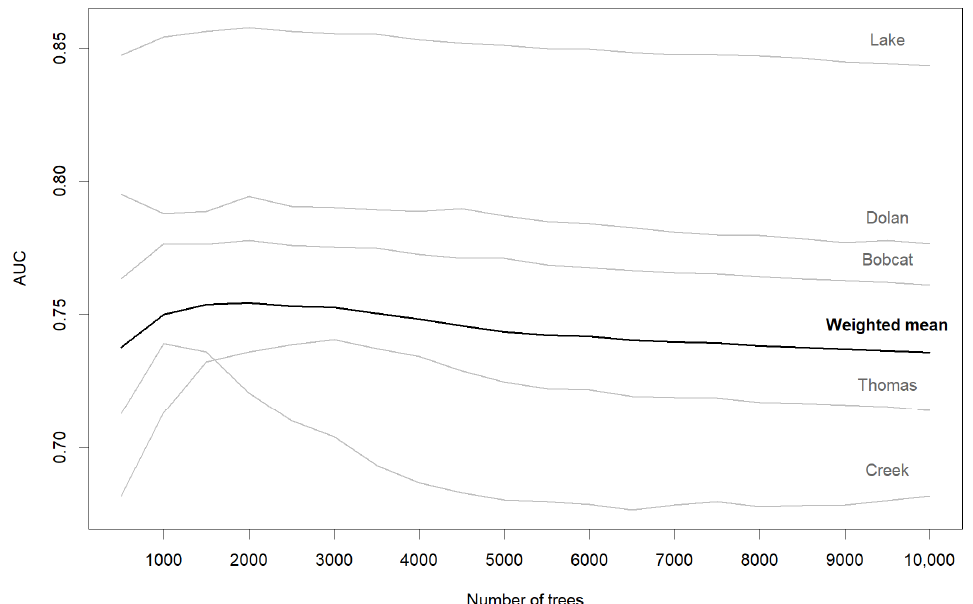
Figure 6. Area under the receiver operating characteristics curve (AUC) results from the cross-validation by fire procedure. A weighted mean was calculated based on the number of observations in each validation set. The results for the five fires with the greatest number of observations are also shown.